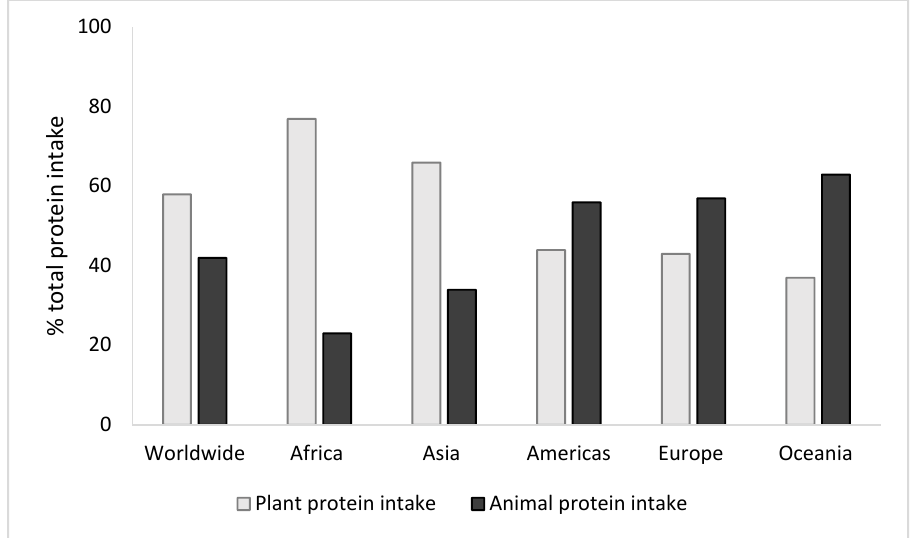
Figure 1. The percentage of dietary protein intake derived from plant and animal protein sources in different parts of the world [45].